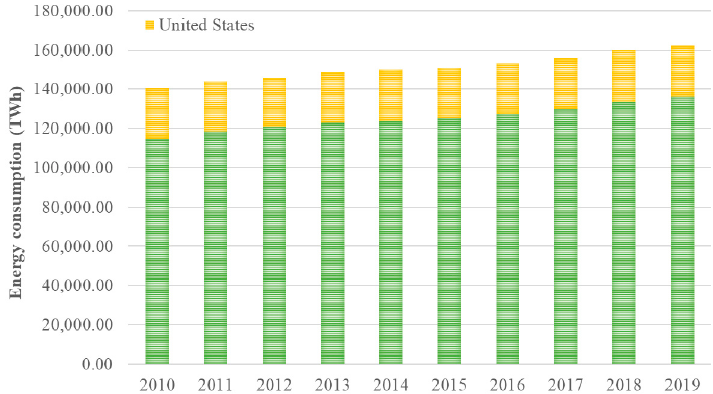
Figure 1. World’s primary energy use vs. the US (adopted from [4]).